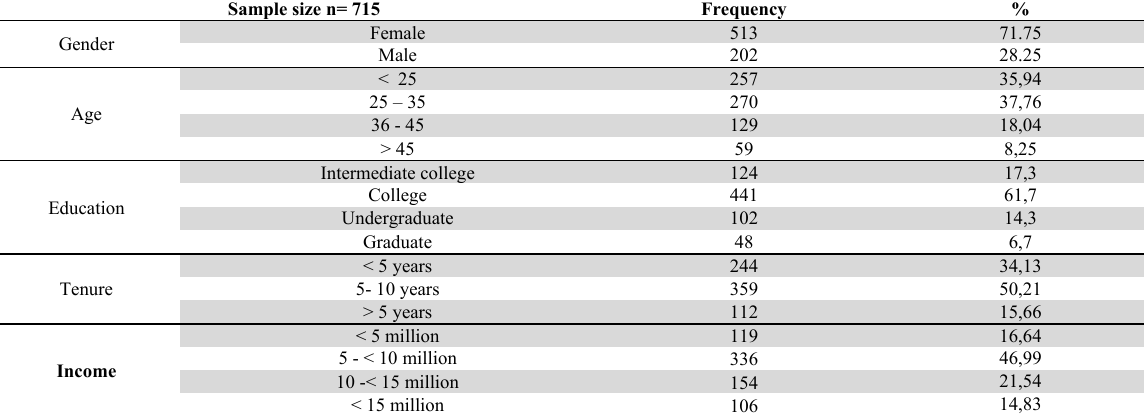
Sample characteristics